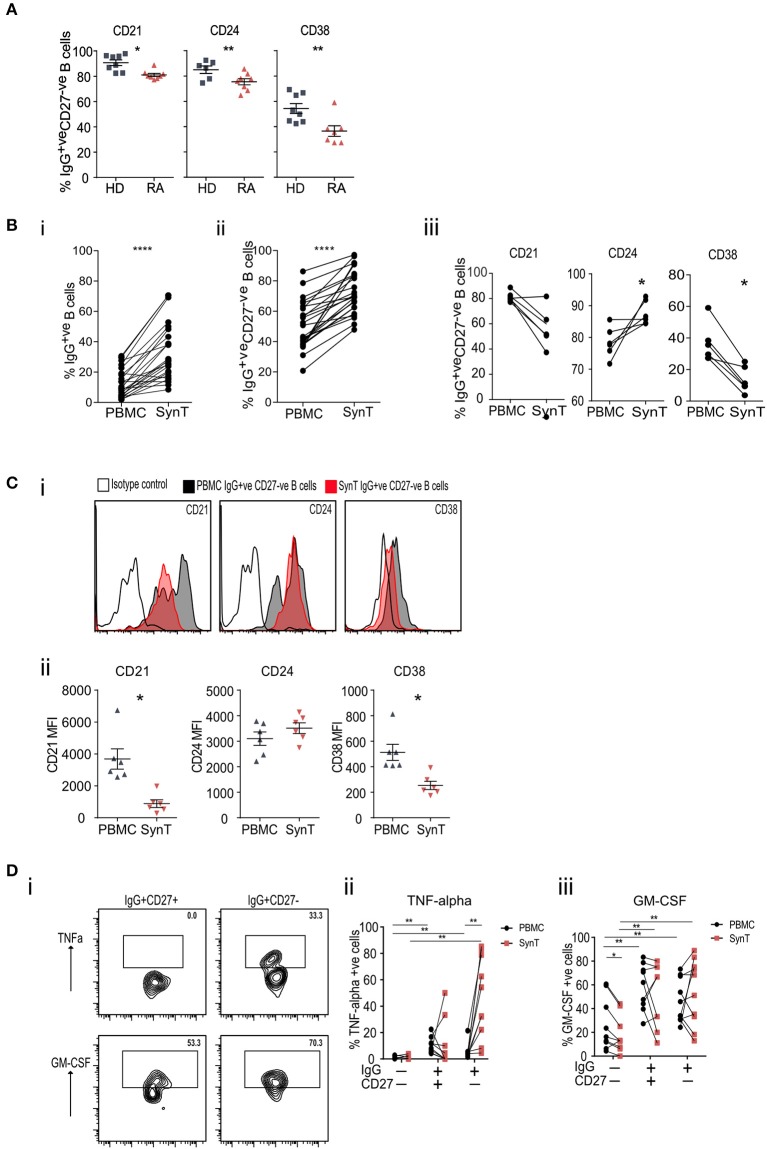
(A) Flow cytometry plots of peripheral blood IgG+veCD27−ve B cells stained for CD21, CD24, and CD38, taken from RA patients at the time of undergoing arthroplasty and compared to healthy donor PBMC. (B) (i) Flow cytometry of paired peripheral blood (PBMC) and synovial tissue (SynT) B cells from RA patients taken at the time of undergoing arthroplasty. The graph shows the percentage of IgG+ve B cells within the CD20+veCD19+ve B cell population. (ii) Percentage of CD20+veCD19+veIgG+veCD27−ve B cells within the IgG+veCD20+veCD19+ve B cell population. For (i) and (ii) n = 24 RA donors. P-value calculated using paired t-test. (iii) Paired RA PBMC and synovial tissue B cells within the IgG+veCD27−ve B cells stained for CD21, CD24 and CD38. n = 6 donors. P-value calculated using Wilcoxon matched-pair T-test. (C) Representative histogram plots of isotype control shown with open black line, PBMC IgG+veCD27−ve (shaded black line) and synovial Tissue IgG+veCD27−ve (shaded red line) (i). (ii) Mean Fluorescence Intensity (MFI) data for individual samples was plotted (ii) for PBMC (gray) and SynT (red) for IgG+ve CD27−ve B cells. n = 6 donors. P-values were calculated using the Wilcoxon paired test. Further surface marker data is shown in Supplementary Figure 9. (D) PBMC and synovial tissue cells were stimulated for 4.5 h with PMA, Ionomycin and Brefeldin A, then stained for intracellular cytokines. Representative flow cytometry plots showing the intracellular cytokine staining of synovial tissue IgG+veCD27−ve and IgG+veCD27+ve B cell subsets for TNF-alpha and GM-CSF (i). Pooled data for PBMC and Synovial tissue (ii) TNF-alpha and (iii) GM-CSF. Each point represents an individual patient sample. n = 9 donors. P-values calculated using Wilcoxon matched-pair test between tissue type or cell type. *p < 0.05, **p < 0.01, ***p < 0.001, ****p < 0.0001.